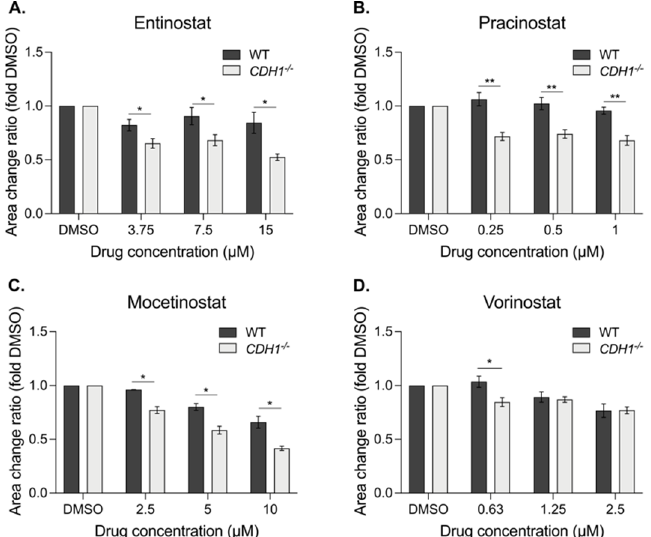
Figure 6. E-cadherin-deficient mammary organoids are more sensitive to pan-HDAC inhibitors. WT and Cdh1 − / − mammary organoids were generated from the same Cre-lox mice than the gastric organoids and drugged with the pan-HDAC inhibitors. The mammary organoids area were then assessed after 48 h of drugging and normalized to their respective DMSO. ( A ) Entinostat induced a synthetic lethal effect, with a maximum of 32% differences at 15 μ M, between WT and Cdh1 − / − organoids. ( B ) Pracinostat decreased Cdh1 − / − growth up to 35% at 0.25 μ M compared to the WT. ( C ) Mocetinostat induced an SL effect, with a maximum of 24% decrease at 10 μ M, in the Cdh1 − / − area compared to WT mammary organoids. ( D ) Vorinostat presented an SL effect at the lowest concentration, with a difference of 19% between the Cdh1 − / − and WT organoids; n = 3–5 per compound. All the IC50 are summarized in Table S5. Statistically significant results are labeled as * p < 0.05 and ** p < 0.01.